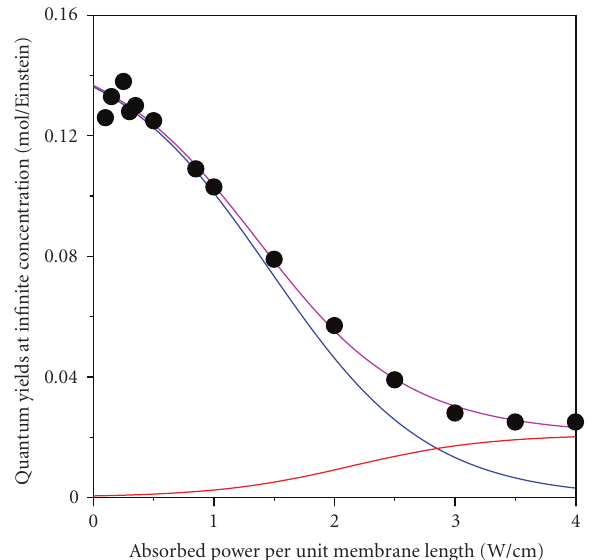
Figure 5: Quantum e ffi ciencies Φ ∞ (mol/Einstein) of methane, extrapolated by (17), at infinite concentration of substrate, evalu- ated as mean values (black dots) relative to measurements in aque- ous solution and in the gaseous phase, reported in Figure 4, as a function of absorbed power per unit length of irradiated photo- catalytic membrane, expressed asW · cm − 1 . The blue curve repre- sents the calculated contribution of reaction (b), as modeled in the present work, decreasing with increasing power. The red curve represents the calculated contribution of reaction (b (cid:8) ), as modeled in the present work, increasing with increasing power. The mauve curve represents equation modeled in the present work, as a sum of both these contributions. Photocatalytic membranes used in the relative experiments did not contain any photopromoting